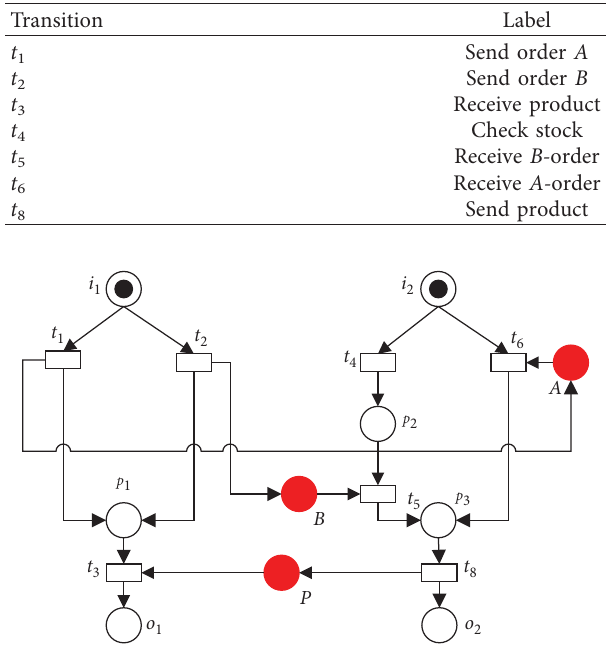
Table 1: Labels of N 1 and N 2 .